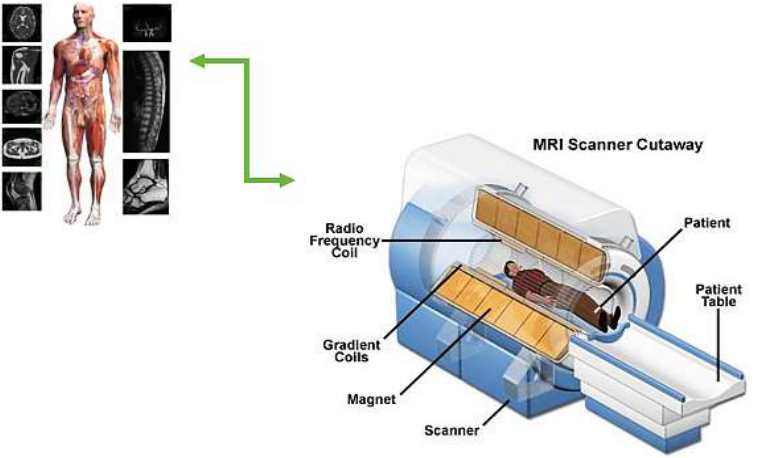
Figure 8: MRI scanner for medical